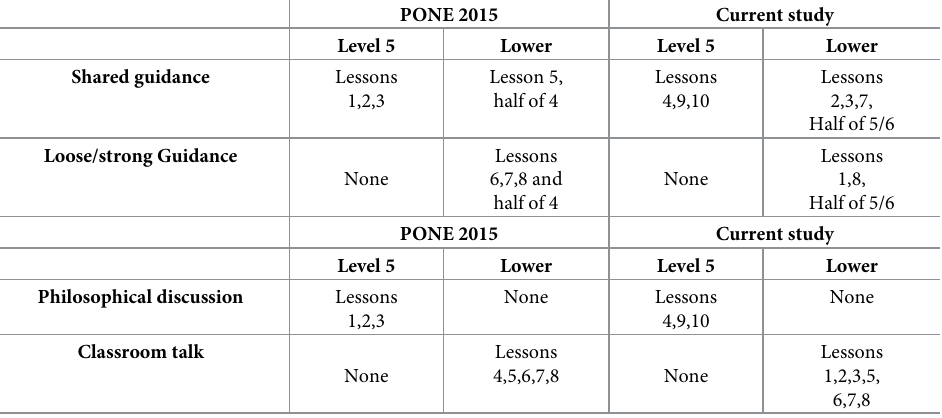
Table 3. Contingency tables showing the relations between the independent variables Guidance (upper tables) and Dialogue (lower tables) in the rows with the dependent variable Level of doing philosophy in the